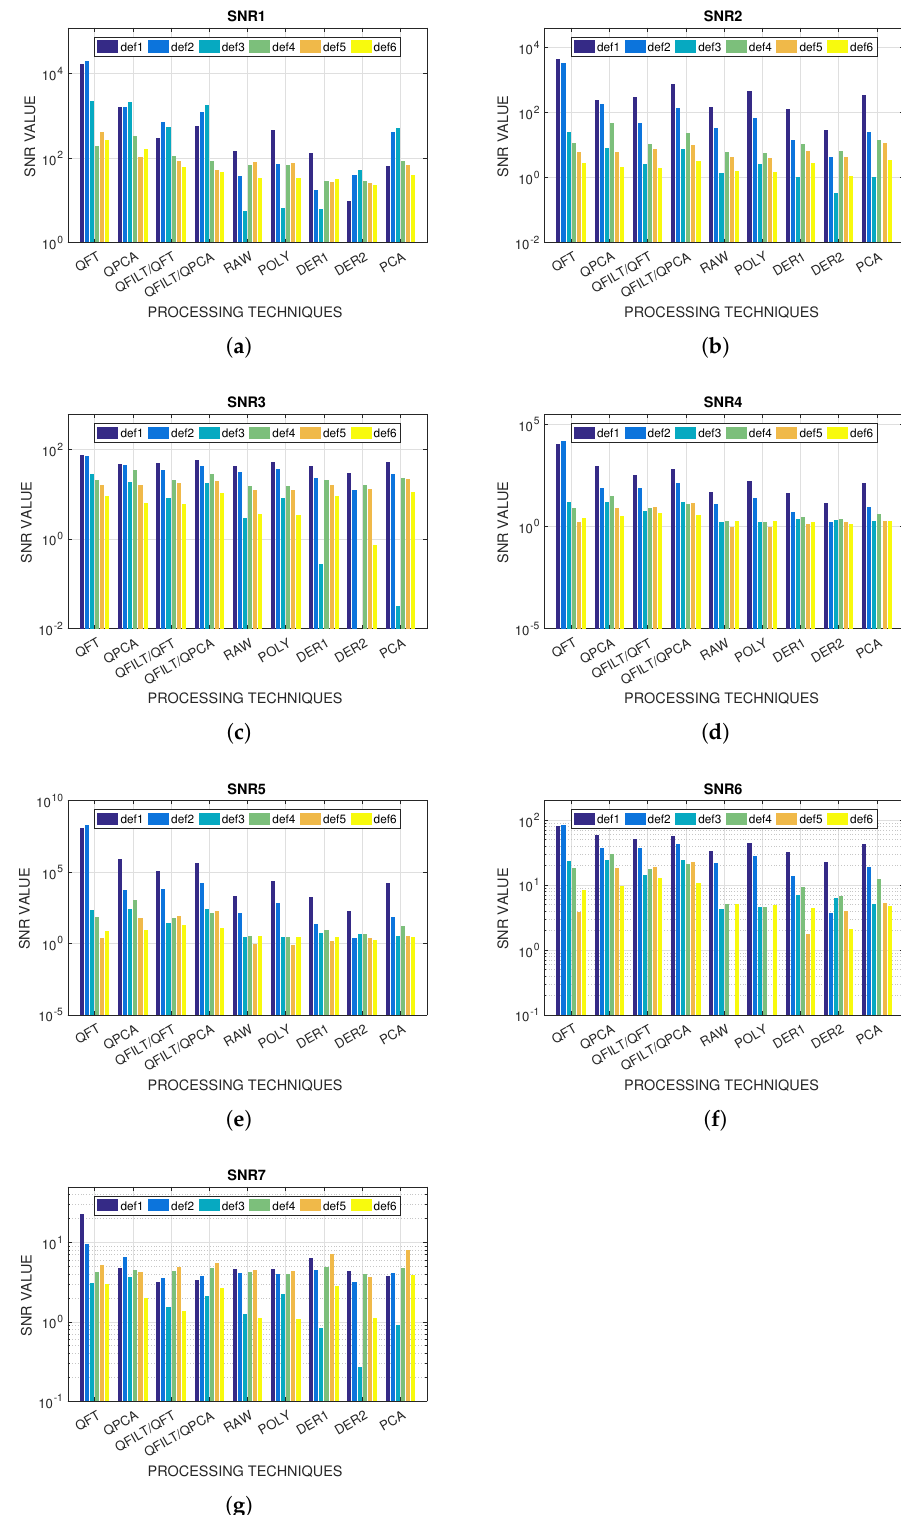
Figure 12. Maximum SNR values obtained with the proposed quaternion processing techniques and the conventional thermographic processing techniques: ( a ) SNR1, ( b ) SNR2, ( c ) SNR3, ( d ) SNR4, ( e ) SNR5, ( f ) SNR6, ( g )